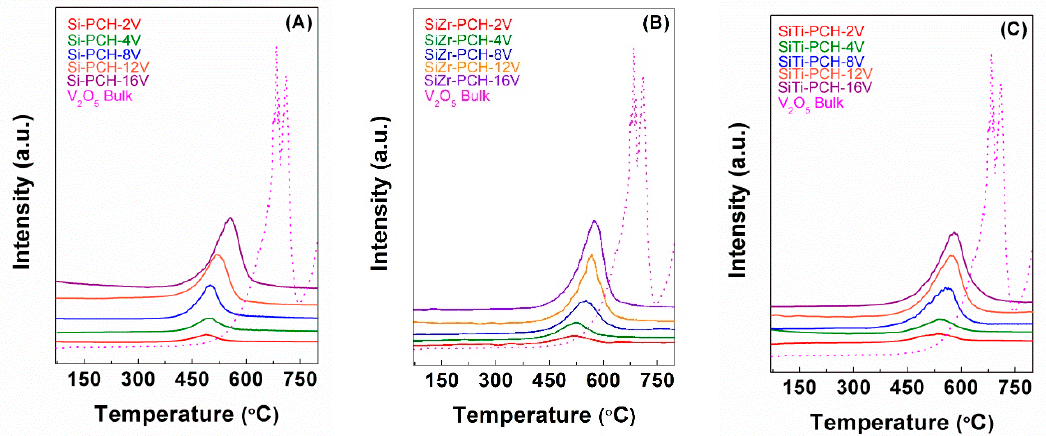
Figure 4. H 2 -TPR of the V-based catalysts supported on Si-PCH ( A ), of the V-based catalysts supported on SiZr-PCH ( B ) and of the V-based catalysts supported on SiTi-PCH ( C ).